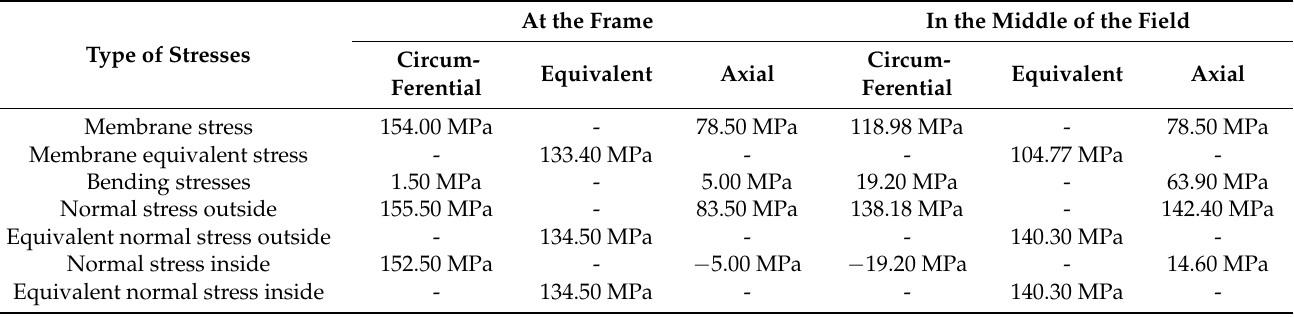
Table A2. Stresses in the free flooding compartment (normal diving depth) for SST 1: Subsea shuttle tanker (Cargo 10,569 m 3